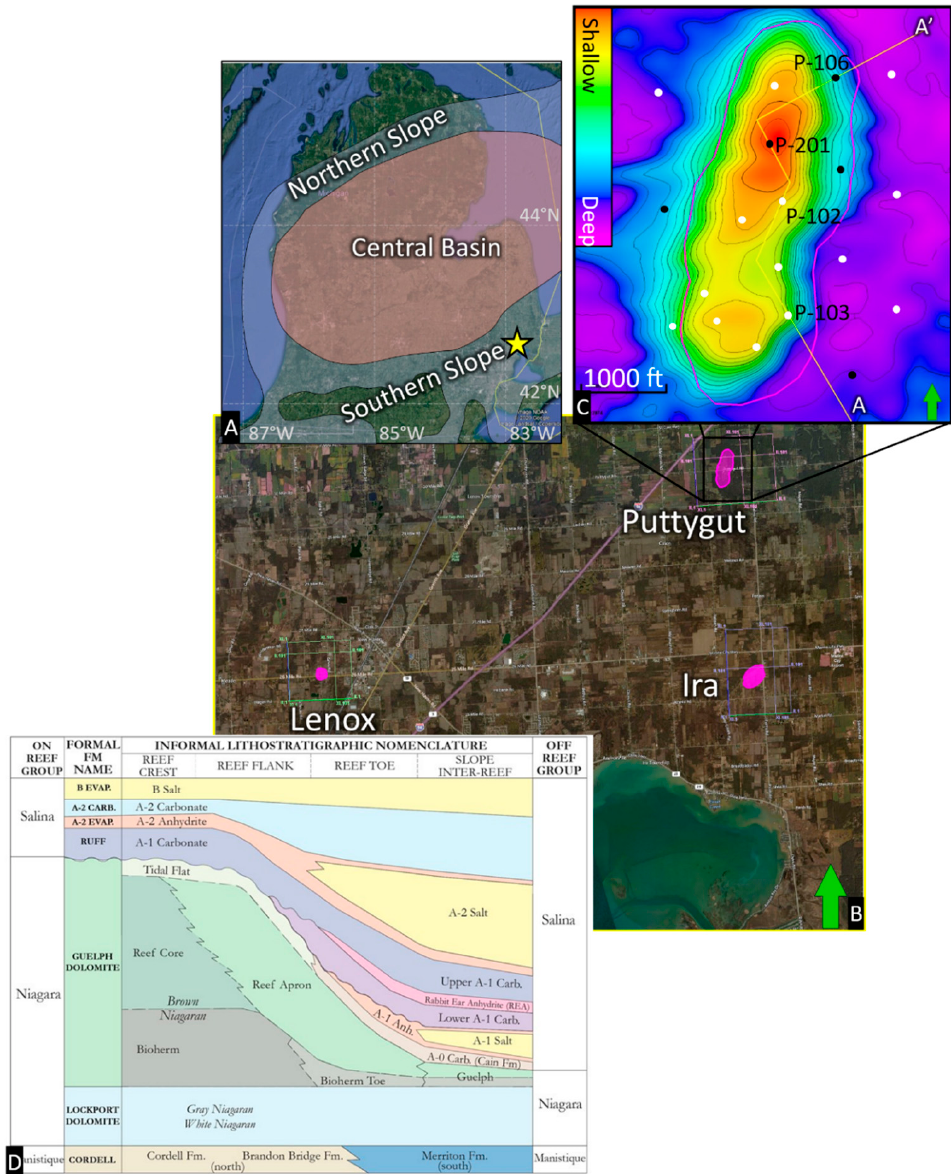
Figure 1. Image ( A ) is a Google Earth image of Michigan. The yellow star is the area of interest. Image ( B ) is a zoom in of the yellow star area showing the three reefs used in this study, Puttygut, Ira, and Lenox. Image ( C ) is a further zoom in of the Puttygut reef showing the two-way time (TWT) map of the Guelph (Brown) Formation. An A-A’ line is drawn through the four wells used in this study. There are also all wells in and near the reef marked by the white and black dots. The black dots represent the wells that were cored. Image ( D ) is a generalized stratigraphic scheme of the reefs in the southern trend of the Michigan Basin from [8]. In this region, the Clinton formation is refered to as the Cordell